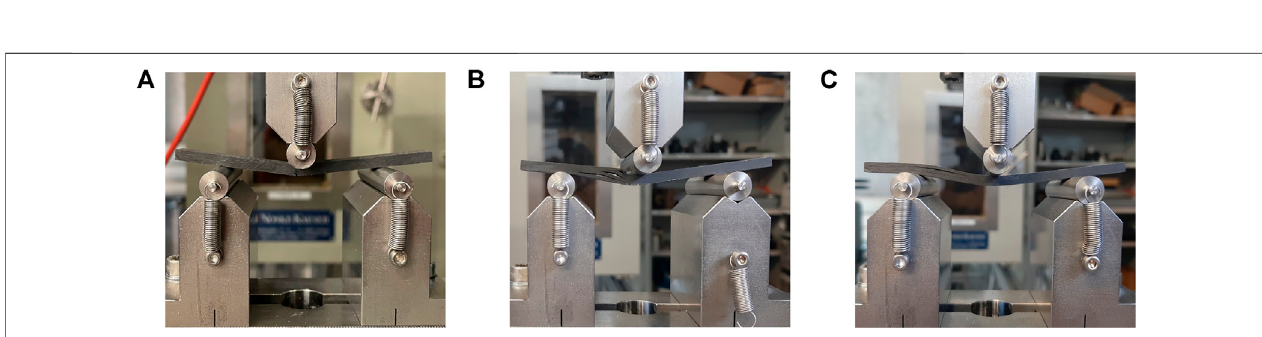
FIGURE 4 | Pictures of the side surface of [(0/90)] 18 samples during the fl exural tests depicting the typical failure of (A) V, (B) D2, and (C) H2 samples.